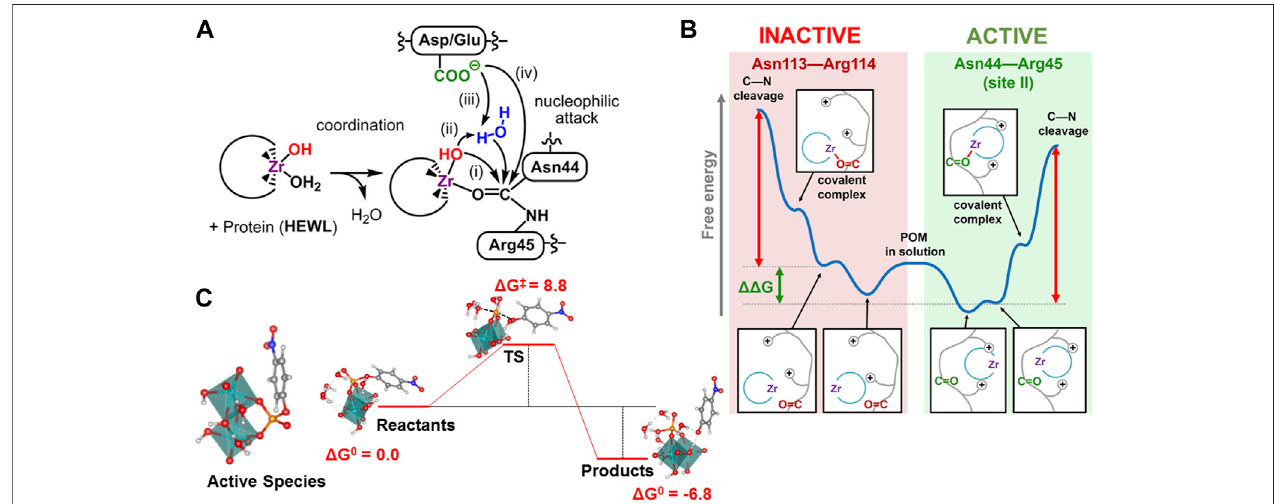
FIGURE2|(A) ComputationallyanalysedmechanismsforthepeptidebondhydrolysisbyZr-substituted POMs: i )inner-sphere, ii )outer-sphere ligand-assisted, iii ) outerspherecarboxylate-assisted, iv )directcarboxylateattack; (B) pictorialrepresentationoftheoriginofselectivityforthepeptidehydrolysisinHEWLbyZr-substituted POMs via enzyme-like recognition; (C) Proposed active species [Mo 2 O 8 H 4 ] 0 , for the hydrolysis of the phosphoester bond of the pNPP model substrate including four explicit water molecules, and the corresponding Gibbs Free Energy pro fi le (kcal · mol − 1